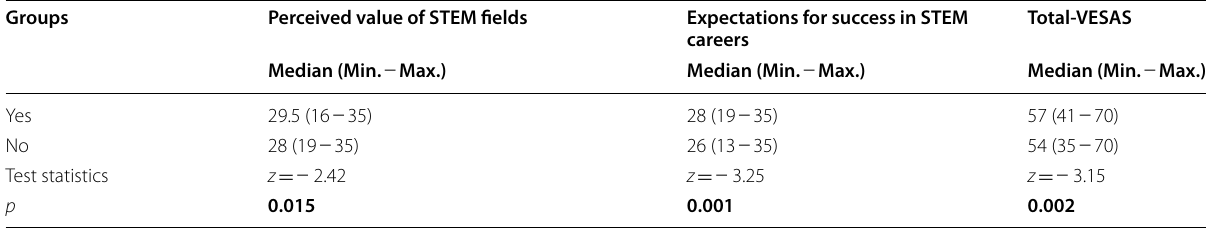
Table 7 The results of Mann Whitney U test for participants’ STEM motivation scores according to the variable of “Having received STEM training” Groups